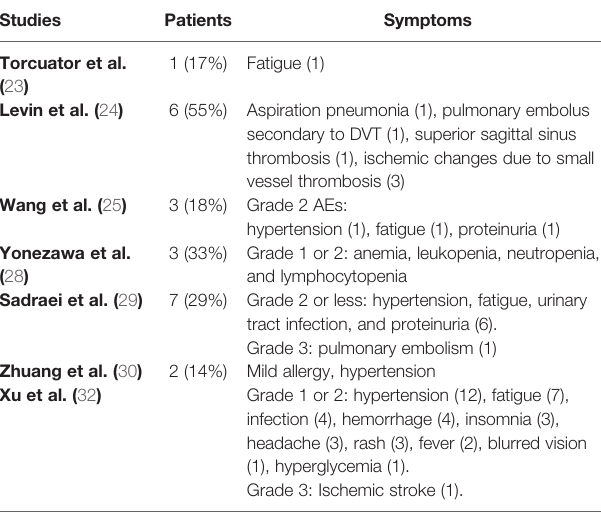
TABLE 5 | Adverse events reported with bevacizumab